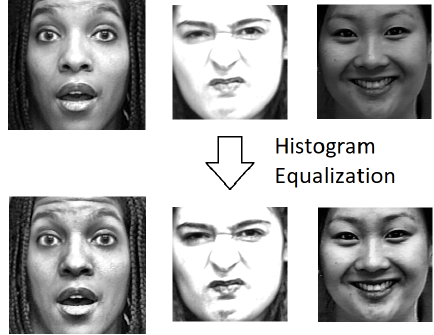
Figure 10. Results in some faces of the CK+ database using